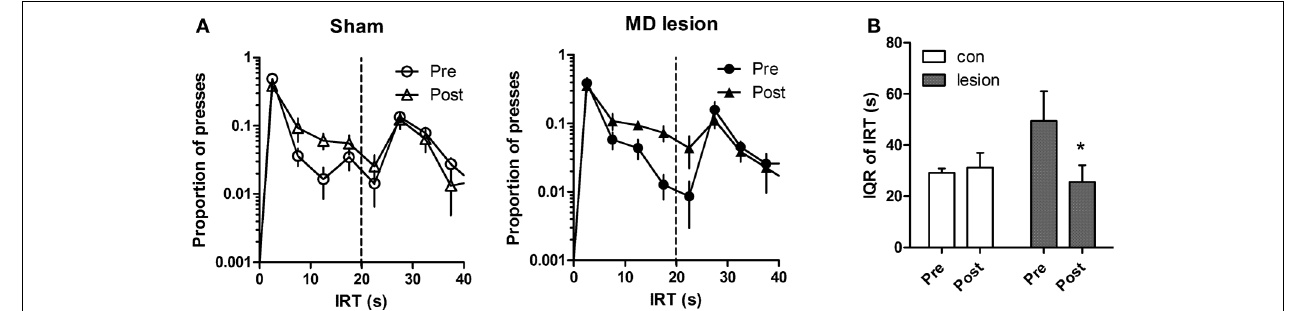
FIGURE 7 | Post-training lesion affects the performance of IRT differentiation. (A) The distribution of IRTs for sham ( n = 8, left) and MD lesion ( n = 7, right) during the last session before surgery (pre) and fi rst test session of